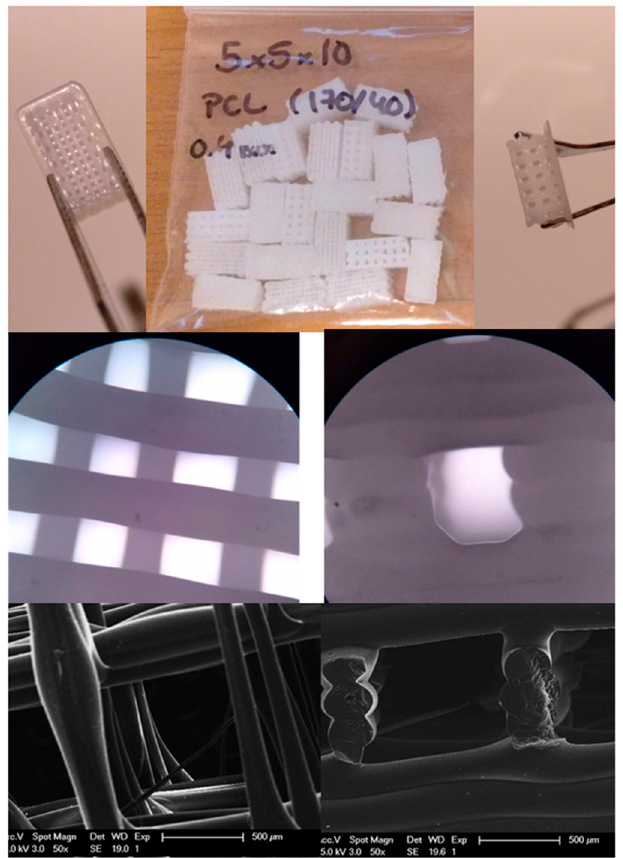
Figure 1. ( Top ). Centre, photograph of 3D printed scaffolds. (left), axial view and (right), lateral view of the scaffolds. ( Medium ). Axial optical microscopy (left) and lateral (right) views of the scaffolds. ( Bottom ). Scanning Electron Microscope (SEM) images from a top section (left) and from a lateral section (right).